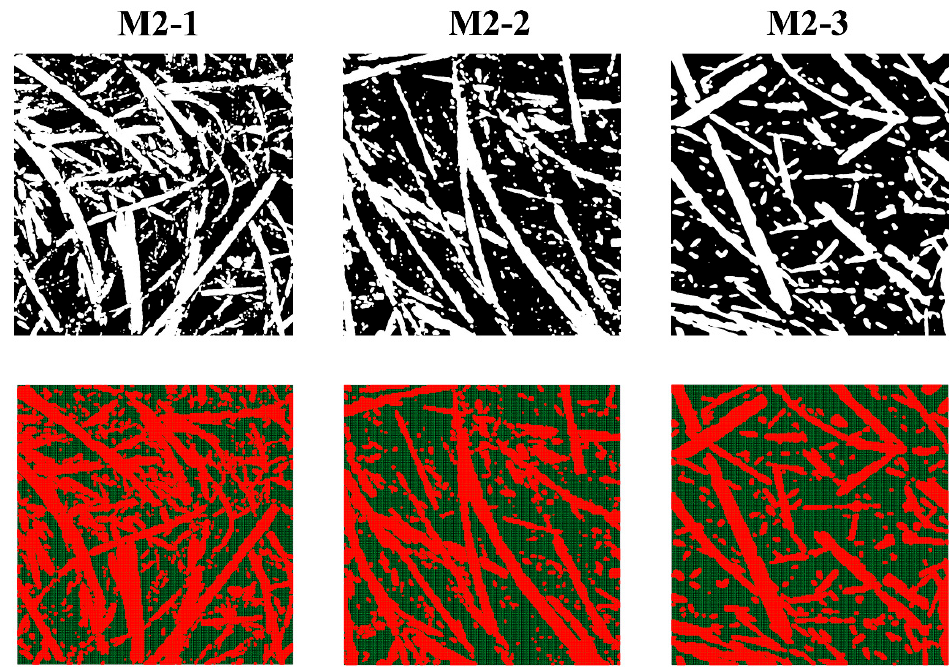
Figure 5. Method 2 modified images and their respective generated FEA meshes. M2-1 stands for Method 2-Sample 1 .